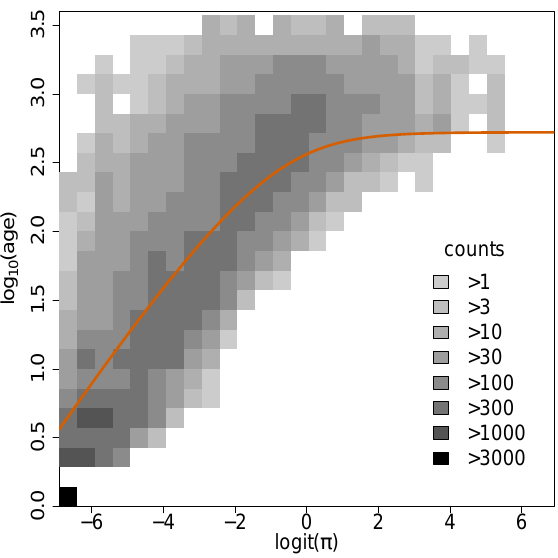
Figure 11 – Relationship between frequency ( π ) and age of mutation. Bidimensional histogram for the frequency and age (in generations) of all mutations in a simulated pop- ulation of N = 500 diploid individuals reproducing predominantly by selfing ( σ = 0.95 ) after 20 N e generations. Theoretical expectation of age orange line (Kimura and Ohta,